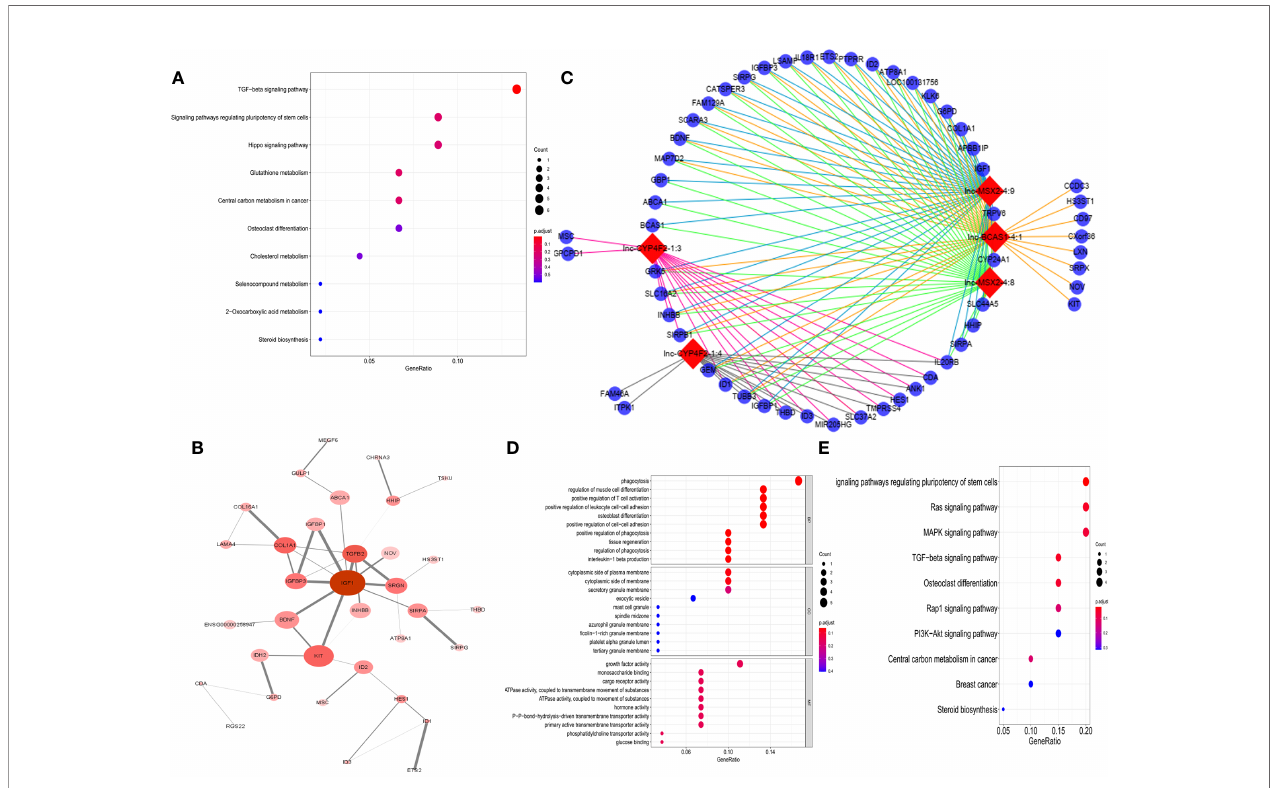
FIGURE 2 | Function analysis of DE-RNAs. (A) The KEGG pathways from total DE-mRNAs, mean enrichment of genes in different pathways. The y-axis represents the pathways, and the x-axis represents enriched gene numbers; the color means adjusted p-value; the most important pathways. (B) The most signi fi cant hub genes identi fi ed by protein – protein interaction (PPI). (C) Vitamin D-regulated lncRNA – mRNA network including top 5 lncRNAs and 140 mapped mRNAs. The red nodes represent top 5 differentially expression lncRNAs, and the blue nodes represent mapped mRNA. (D) GO analysis contains the biological process (BP), cellular component (CC), and molecular function (MF). The x-axis represents the gene ratio, and the y-axis represents GO terms. The size of the circle indicates the gene count, and the color means adjusted p-value. (E) The KEGG pathways from top 5 lncRNA regulated-DE mRNAs. The y-axis represents the pathways, and the x-axis represents enriched gene numbers; the color means adjust